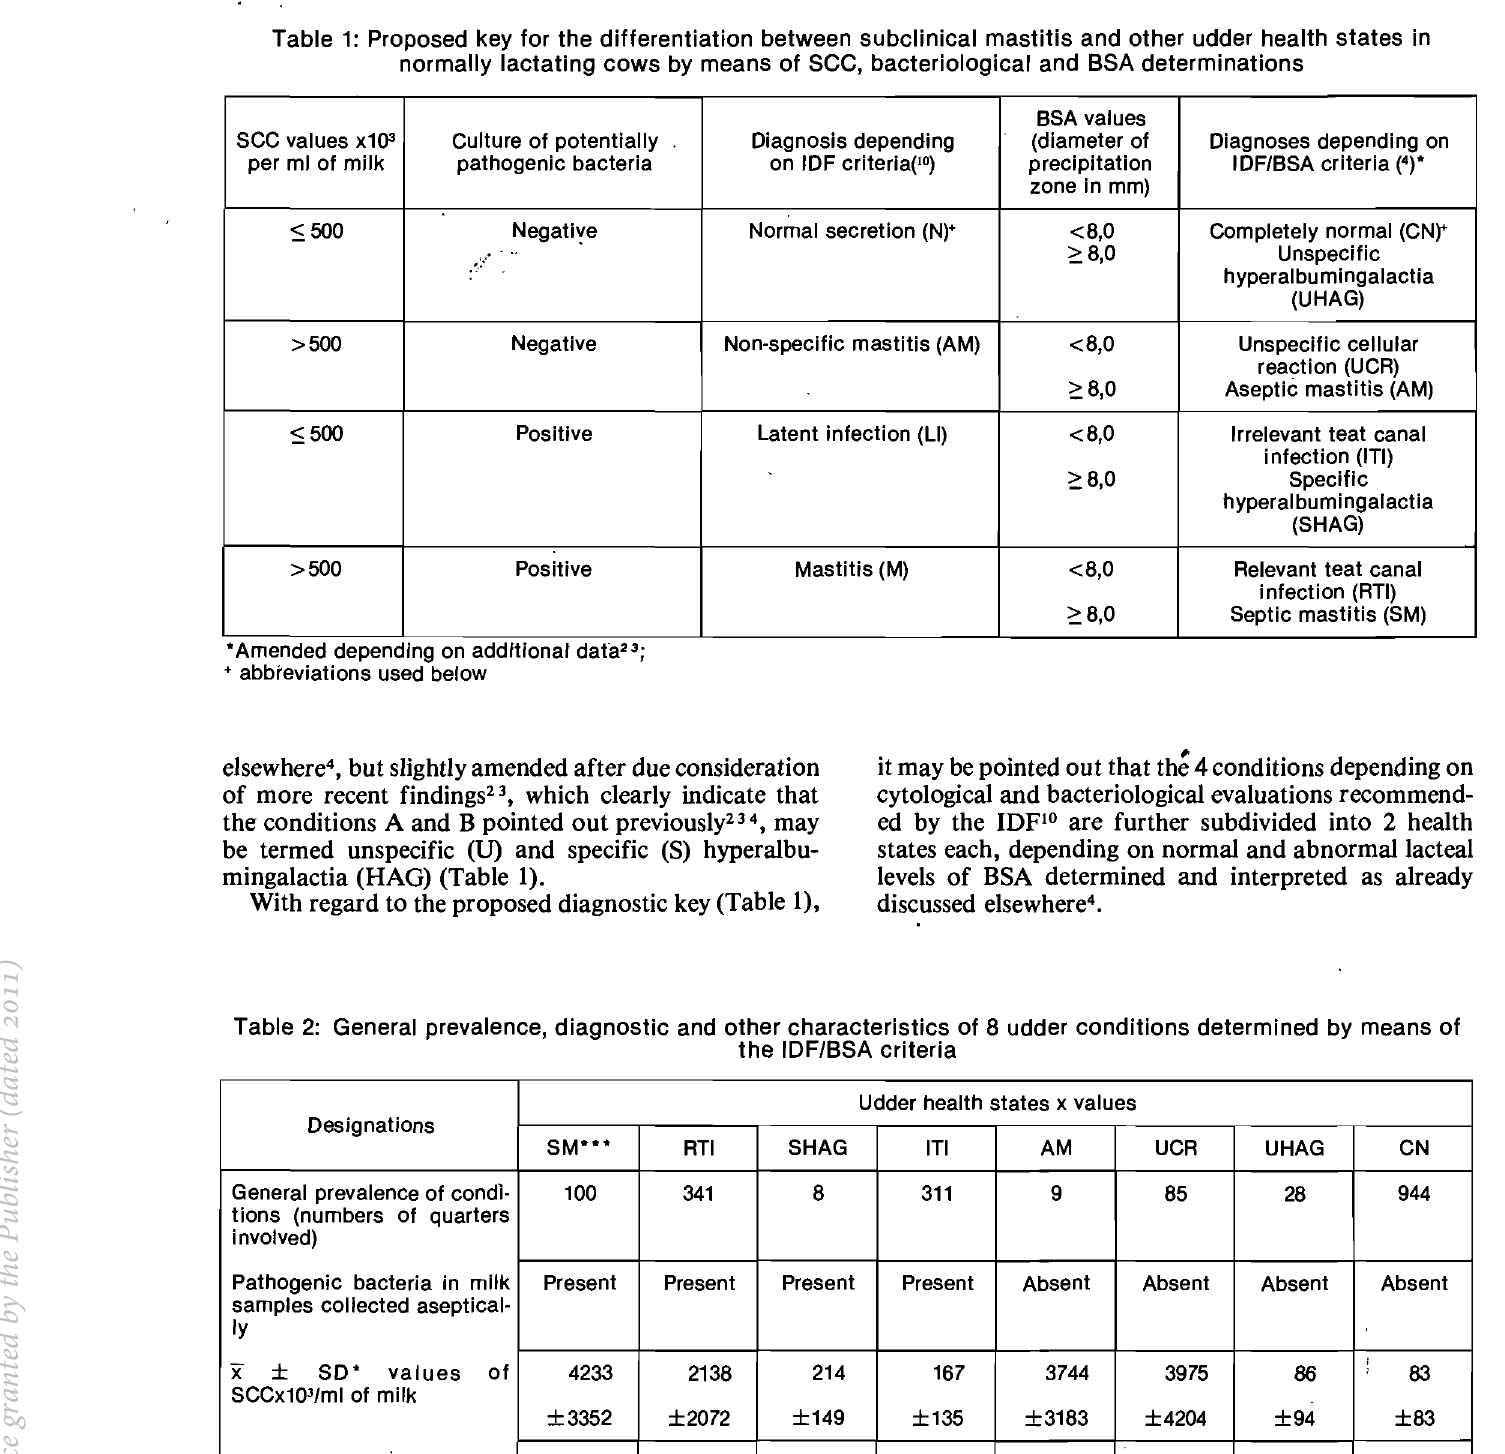
Table 1: Proposed key for the differentiation between subclinical mastitis and other udder health states in normally lactating cows by means of sec, bacteriological and BSA determinations